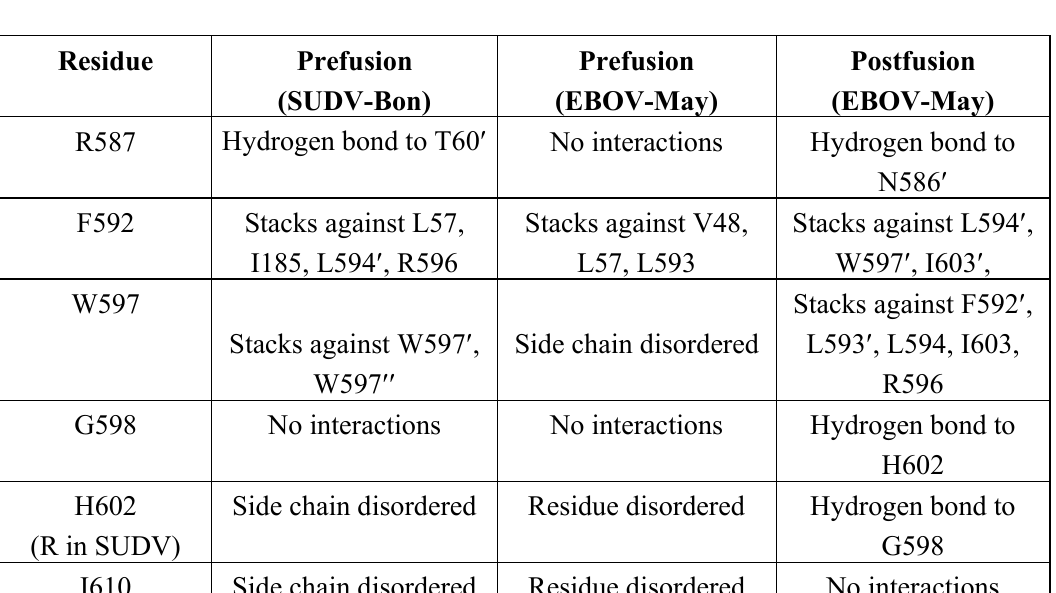
Table 1: Interactions made by key residues in the “chain reversal region” in pre-fusion and post-fusion forms of ebolavirus GP 1,2.